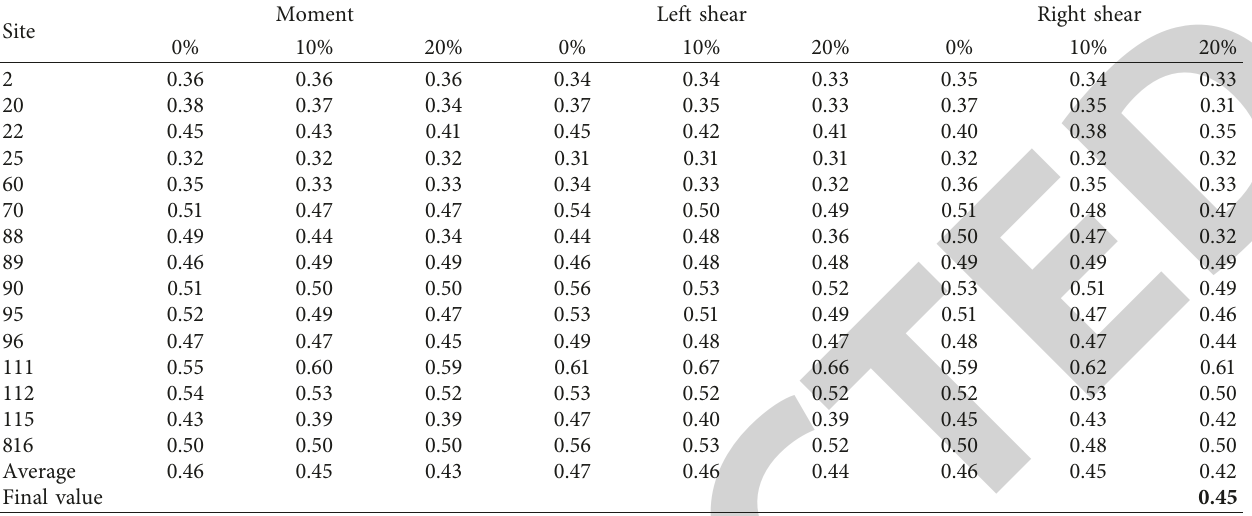
Table 2: Ratios for equations (8) and the 15 sites.